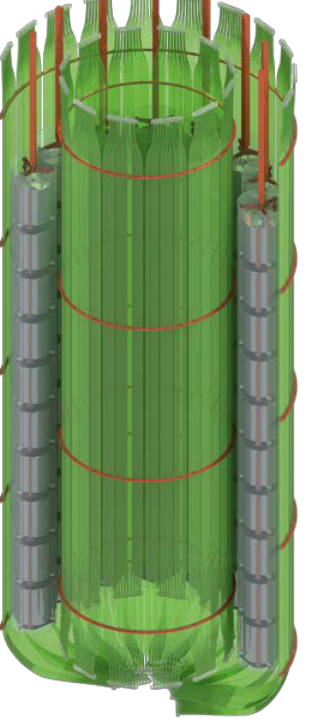
Fig. 3. Rendering of the LEGEND-200 fiber instrumentation, showing the inner fiber barrel, the 14 Ge strings and the outer fiber barrel (the latter two being cut for better visibility).